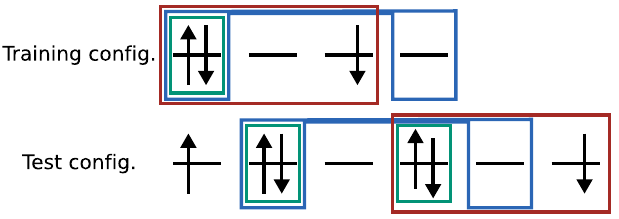
FIG. 1. Exemplification of the kernel function feature space. The kernel counts correlation features common to the test configuration (bottom) and training configuration (top), includ- ing, e.g., the single-site Gutzwiller feature (green), two-site features explicit in the Jastrow wave function (blue), and nearest-neighbor plaquette features used in EPS ansatzes